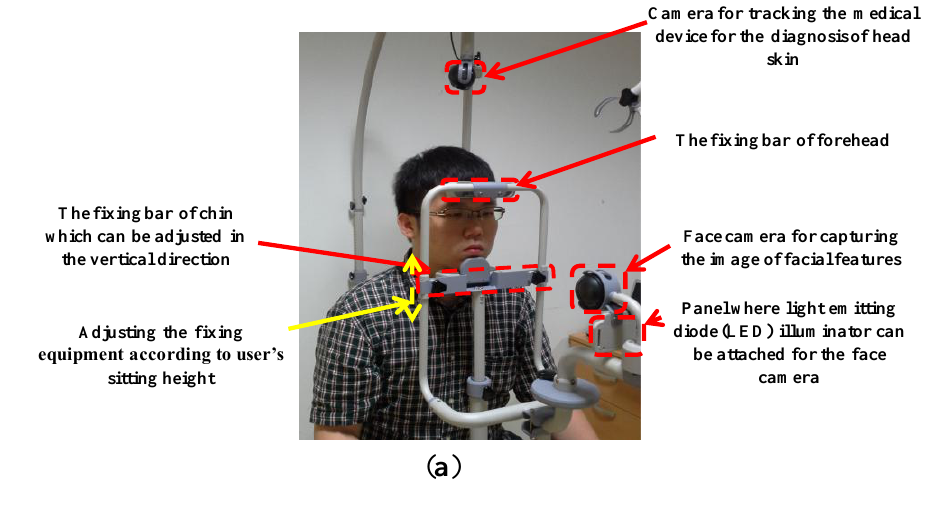
Figure 4. Proposed system. ( a ) Equipment to immobilize the chin and forehead of a patient; ( b ) Rotating/moving part of camera for tracking the medical